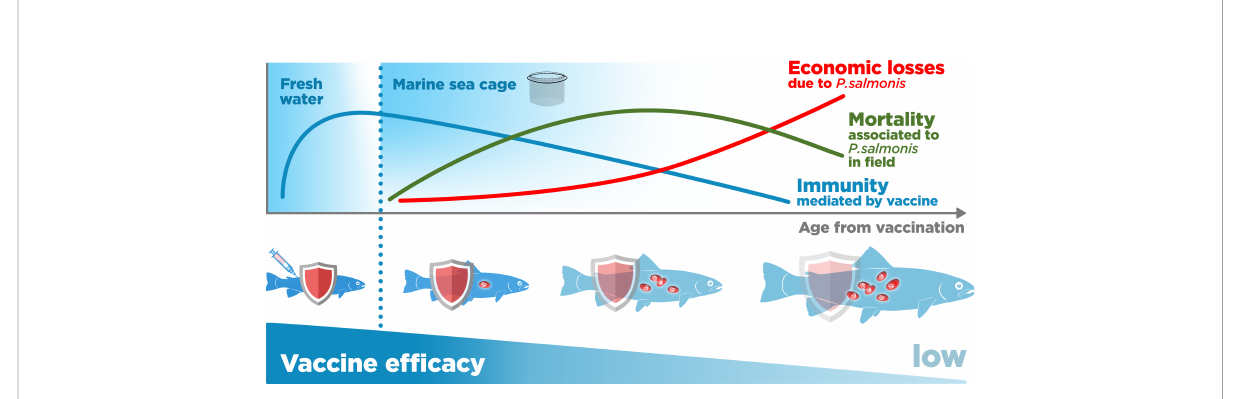
FIGURE 7 Piscirickettsia salmonis vaccination-mediated immunity and its relationship with mortality and economic losses in salmon farming in sea cages.